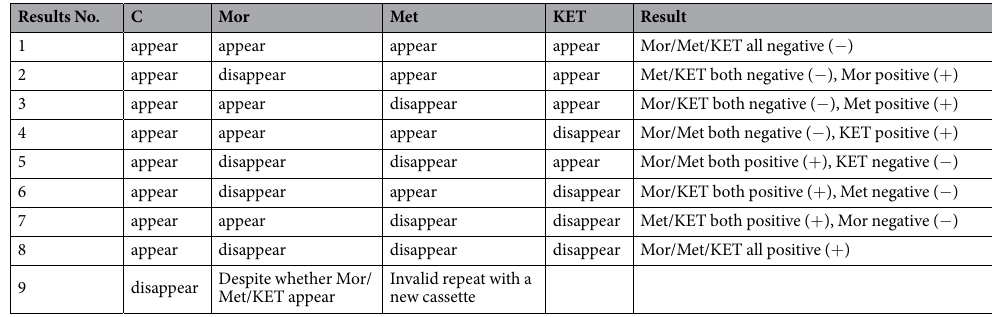
Table 3. Interpretation of the Morphine & Methamphetamine & Ketamine Diagnostic